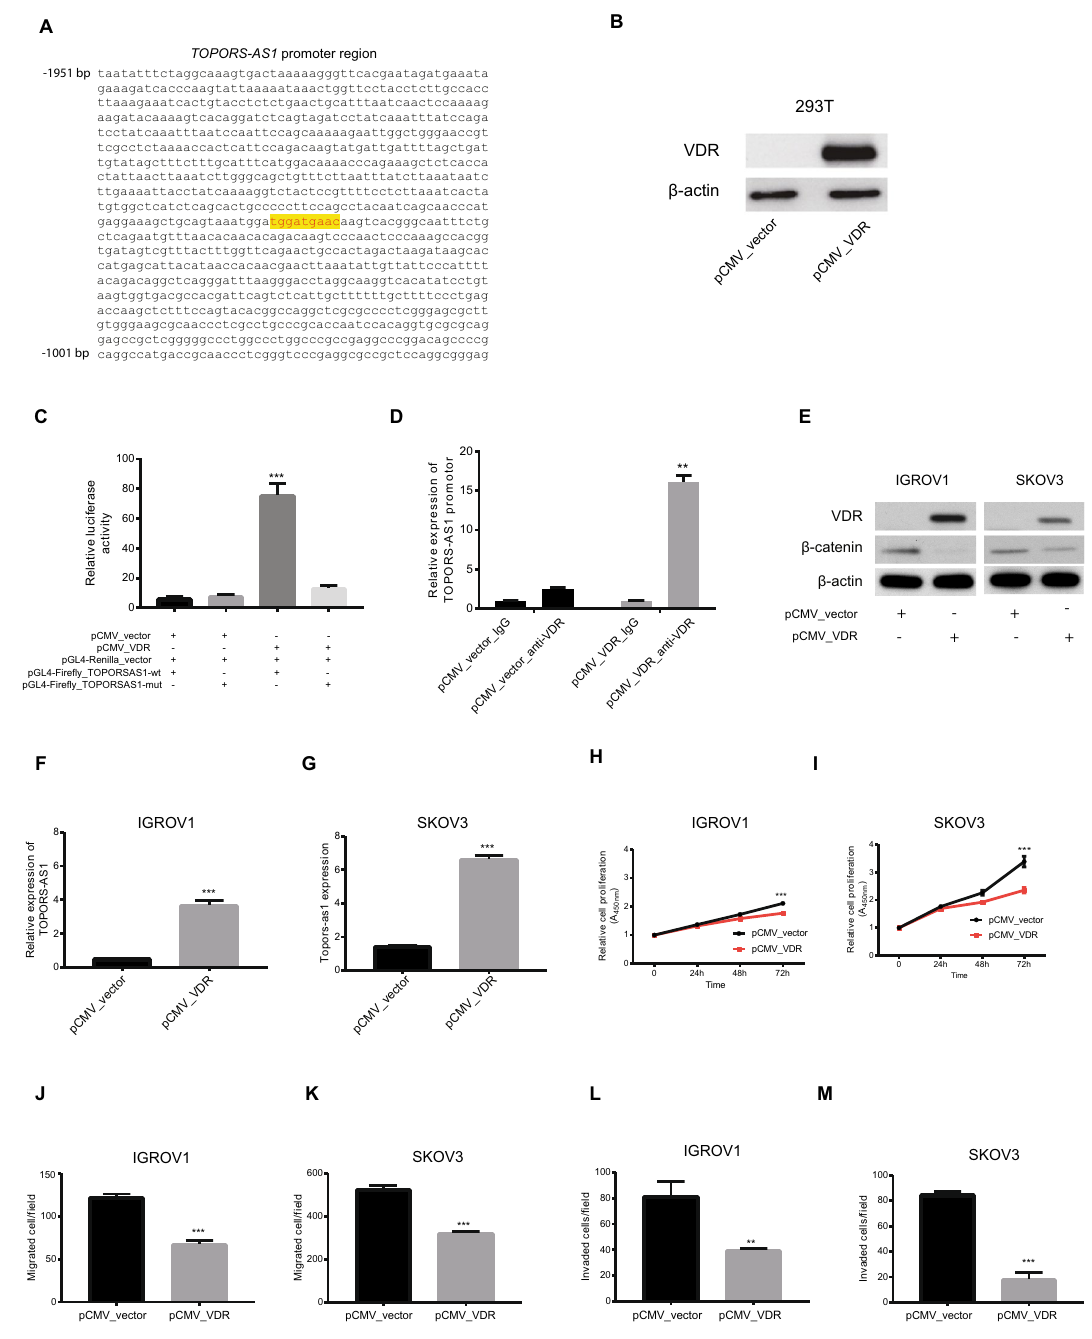
Figure 4. Upregulation of TOPORS-AS1 expression by VDR and its effect on tumor cell proliferation, migration, and invasion. ( A ) PROMO prediction of a VDR binding site in the TOPORS-AS1 promoter. ( B ) Western blot results showing increased VDR expression in 293 T after transfecting the cells with a pCMV_VDR plasmid. ( C ) Luciferase reporter assay results showing increased luciferase activity in 293 T cells co-transfected with the VDR plasmid (pCMV_VDR) and luciferase reporter gene linked to TOPORS-AS1-wt (wild type) and no increase in TOPORS-AS1-mut (mutated). ( D ) Chromatin immunoprecipitation (ChIP) results suggesting VDR binding to the TOPORS-AS1 promoter. ( E ) Western blot results showing increased VDR and decreased β-catenin in IGROV1 and SKOV3 after VDR transfection. ( F , G ) RT-qPCR results showing increased TOPORS-AS1 expression in IGROV1 and SKOV3 after VDR transfection. ( H , I ) Cell proliferation assay showing slower IGROV1 and SKOV3 proliferation after VDR transfection. ( J , K ) Cell transwell migration assay showing fewer migrated IGROV1 and SKOV3 after VDR transfection. ( L , M ) Cell transwell invasion assay showing fewer invaded IGROV1and SKOV3 after VDR transfection. ***P < 0.0001; **P <